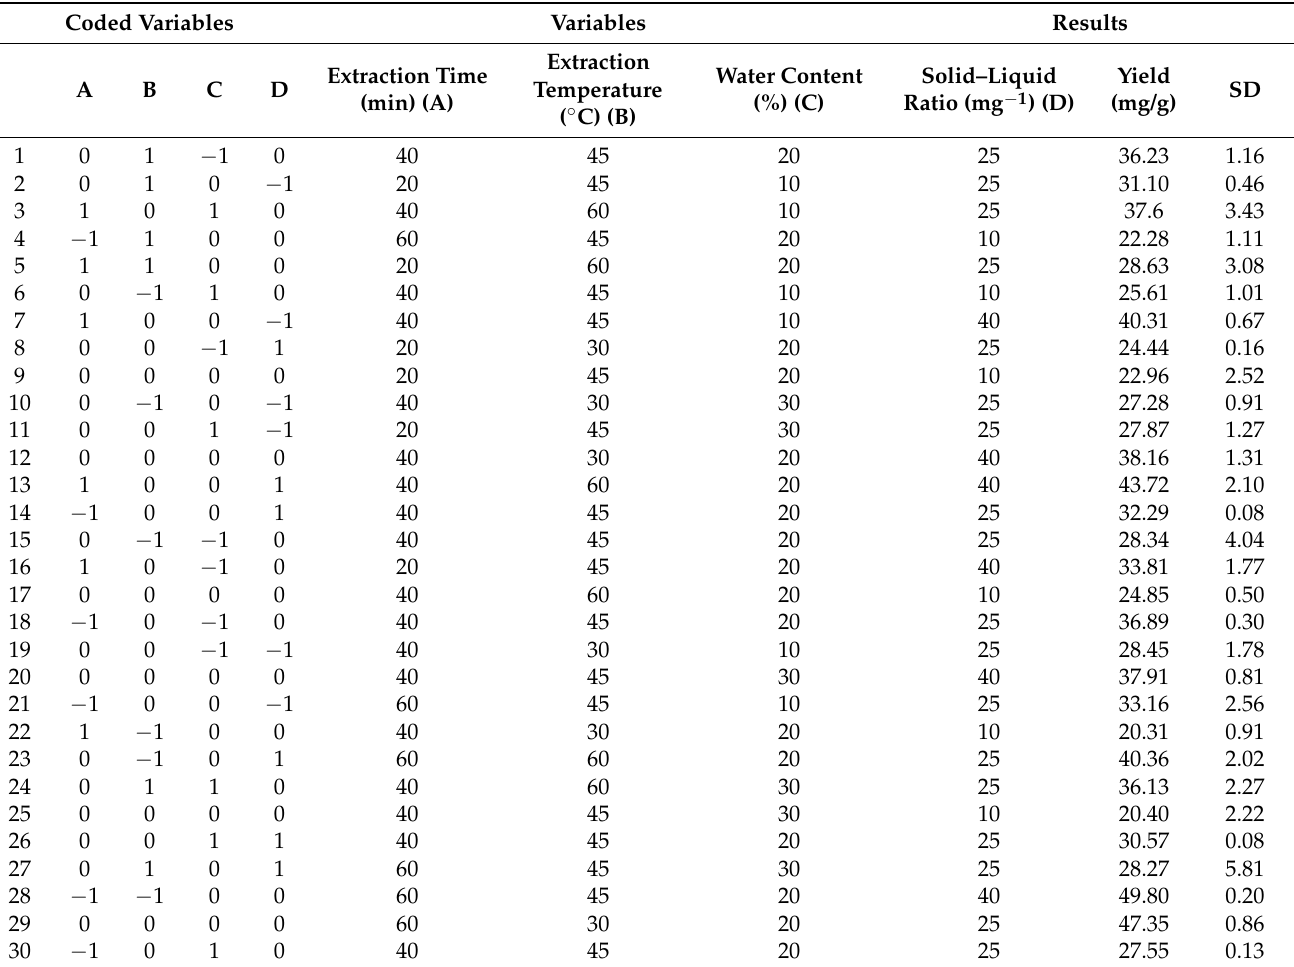
Table 2. Results of the response surface experiment (Box–Behnken design) for optimization of the independent variables used in deep eutectic solvent extraction of piperine from Piper nigrum